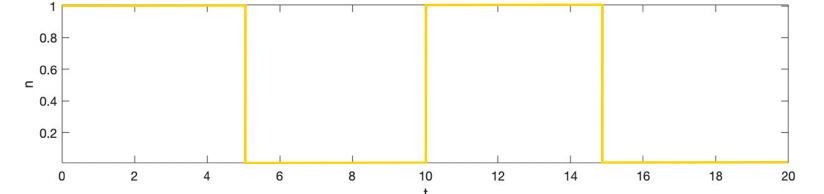
Figure A2. The chosen ˙ n , n as a Function of t, to be used in the